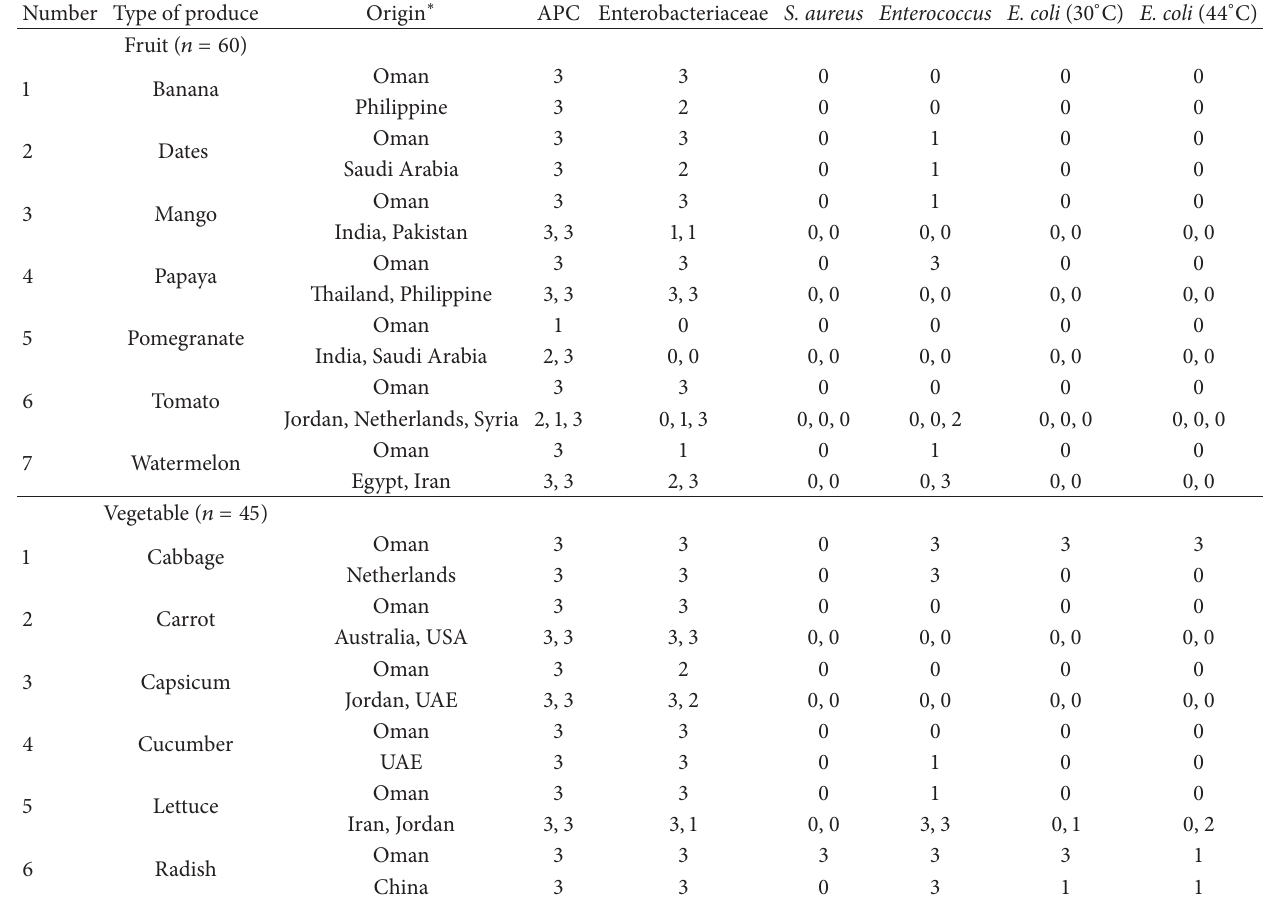
Table 1: Origin of fruits and vegetables and the number of positive samples for different microbial counts. Number Type of